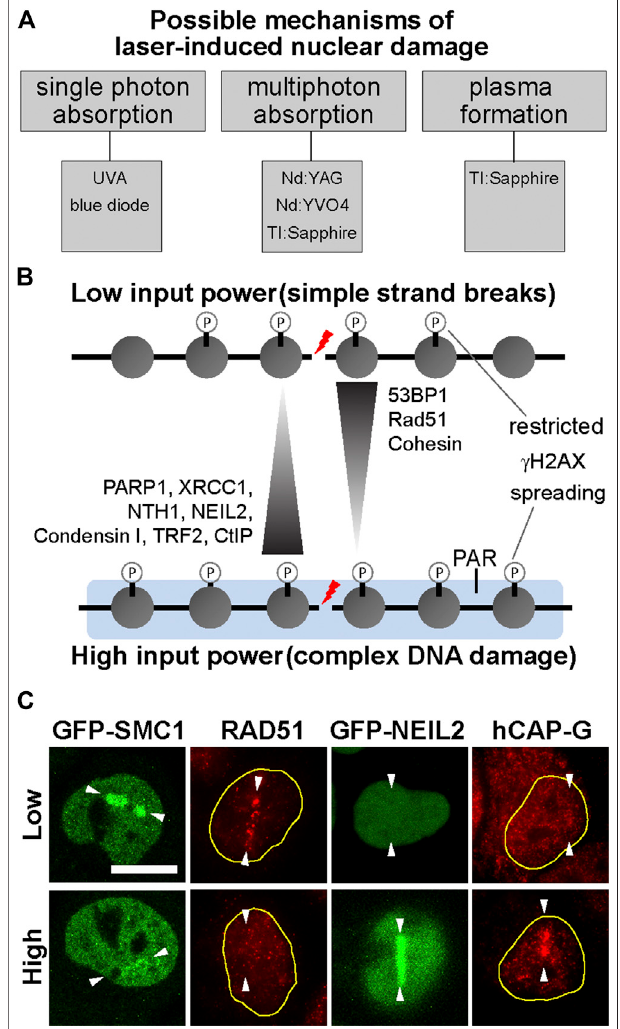
FIGURE 1 | Simple strand breaks and complex damage induced by NIR laser microirradiation with low and high input power. By adjusting parameters, laser microirradiation can enrich differenttypes and amounts of DNA damage with the recruitment of different repair factors. (A) Suggested mechanisms of laser induced nuclear damage and corresponding common laser sources for damage induction. Speci fi c wavelength and other laser parameters are summarized in Supplementary Table S1 . Modi fi ed from [22]. (B) Schematic diagram of differential DNA damage responses to low and high input power NIR laser microirradiation. Forrelativelysimplestrandbreaksinducedbylowpowerlaser(top),ef fi cient 53BP1, Rad51 and SMC1 (cohesin) recruitment occurs while no signi fi cant PARP activation is observed. In contrast, complex damage containing crosslinking and base damage as well as high-density strand breaks induces robust PARP activation, spreading of H2AX phosphorylation from damage sites ( γ H2AX, the marker of DSBs), and recruitment of repair factors in NER and BER pathways. Blue box: PAR accumulation [37]. (C) Fluorescent microscope images of human cells damaged with low and high input power laser microirradiation. Cohesin (GFP-SMC1) and Rad51 involved in HR repair are preferentially recruited to low input power damage sites (top) while DNA glycosylase (GFP-NEIL2) and condensin I (hCAP-G) involved in BER/SSB repair are enriched at high input power damage sites (bottom). Damage sites are indicated by white arrowheads. Bar (cid:1) 10 μ m [37,